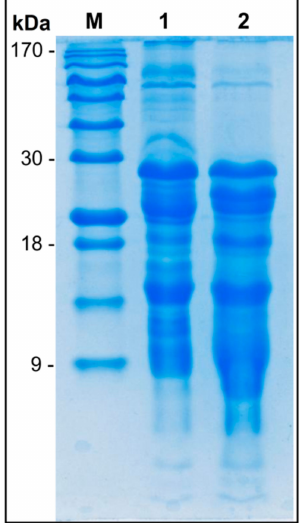
Figure 4. ProteinseparationproductsobtainedfromSDS-PAGE(sodiumdodecylsulphate-polyacrylamide gel electrophoresis) analysis. Lane M contains a protein molecular weight marker. Lane 1 and 2—cheese samples before and after ripening,